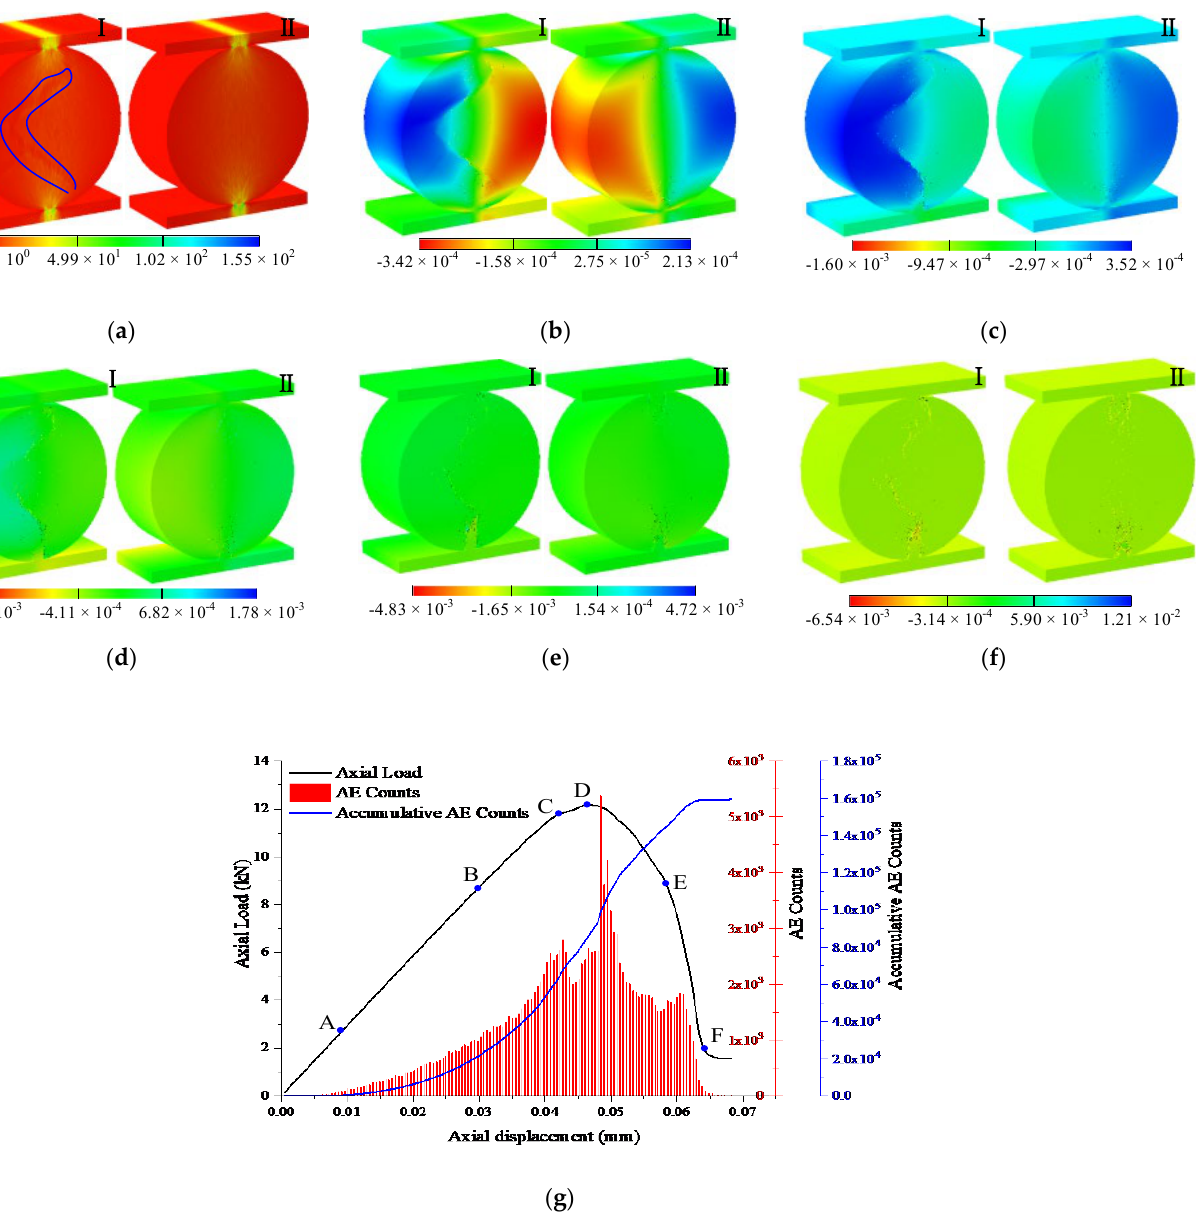
Figure 10. Numerical simulation of the shale sample at the mesoscale. ( a ) Maximum principal stress. ( b – f ) Vertical displacement contours at different loading stages, ( a – f ) correspond to points A–F in ( g ), respectively. ( І ) front view, and ( ІІ ) back view. ( g ) The stress–strain curve associated with AE counts for shale. The unit of stress in ( a ) is the MPa, and the unit of displacement in ( b – f ) is the millimeter.